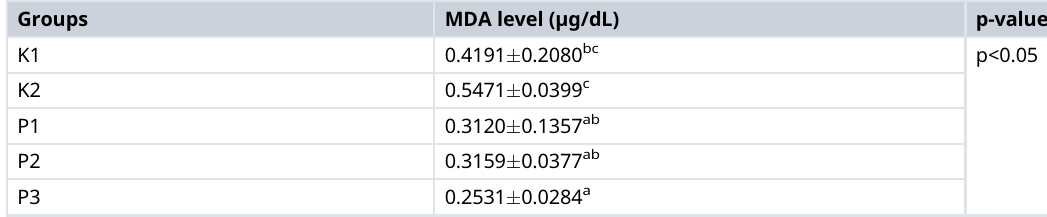
Table 2. Comparison of the MDA level results before and after treatment with RDF extract and the results of the One-Way ANOVA test. Groups